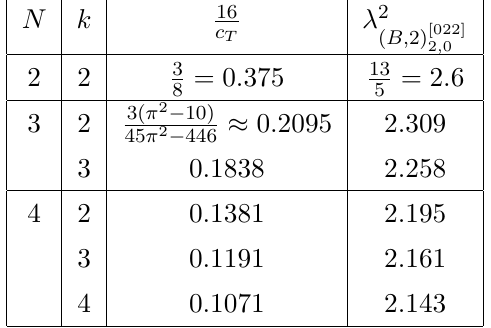
Table 9 . OPE coefficients 16